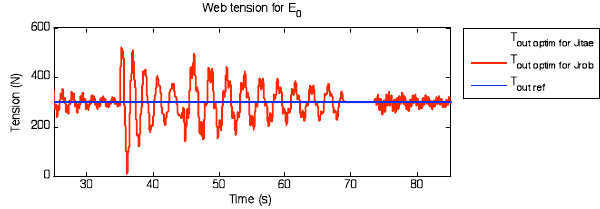
Fig. 17. Optimized PI controllers simulation results for or using switching strategy (for 5*